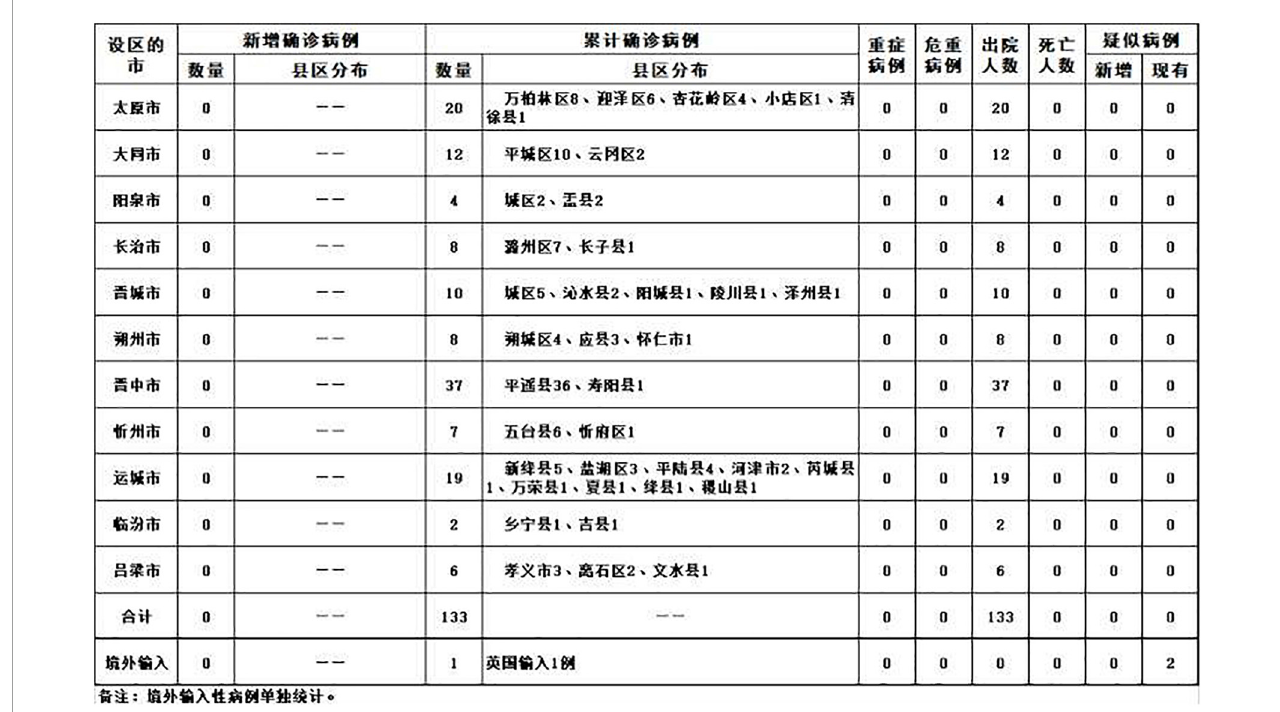
FIGURE3 Example of an outbreak trend